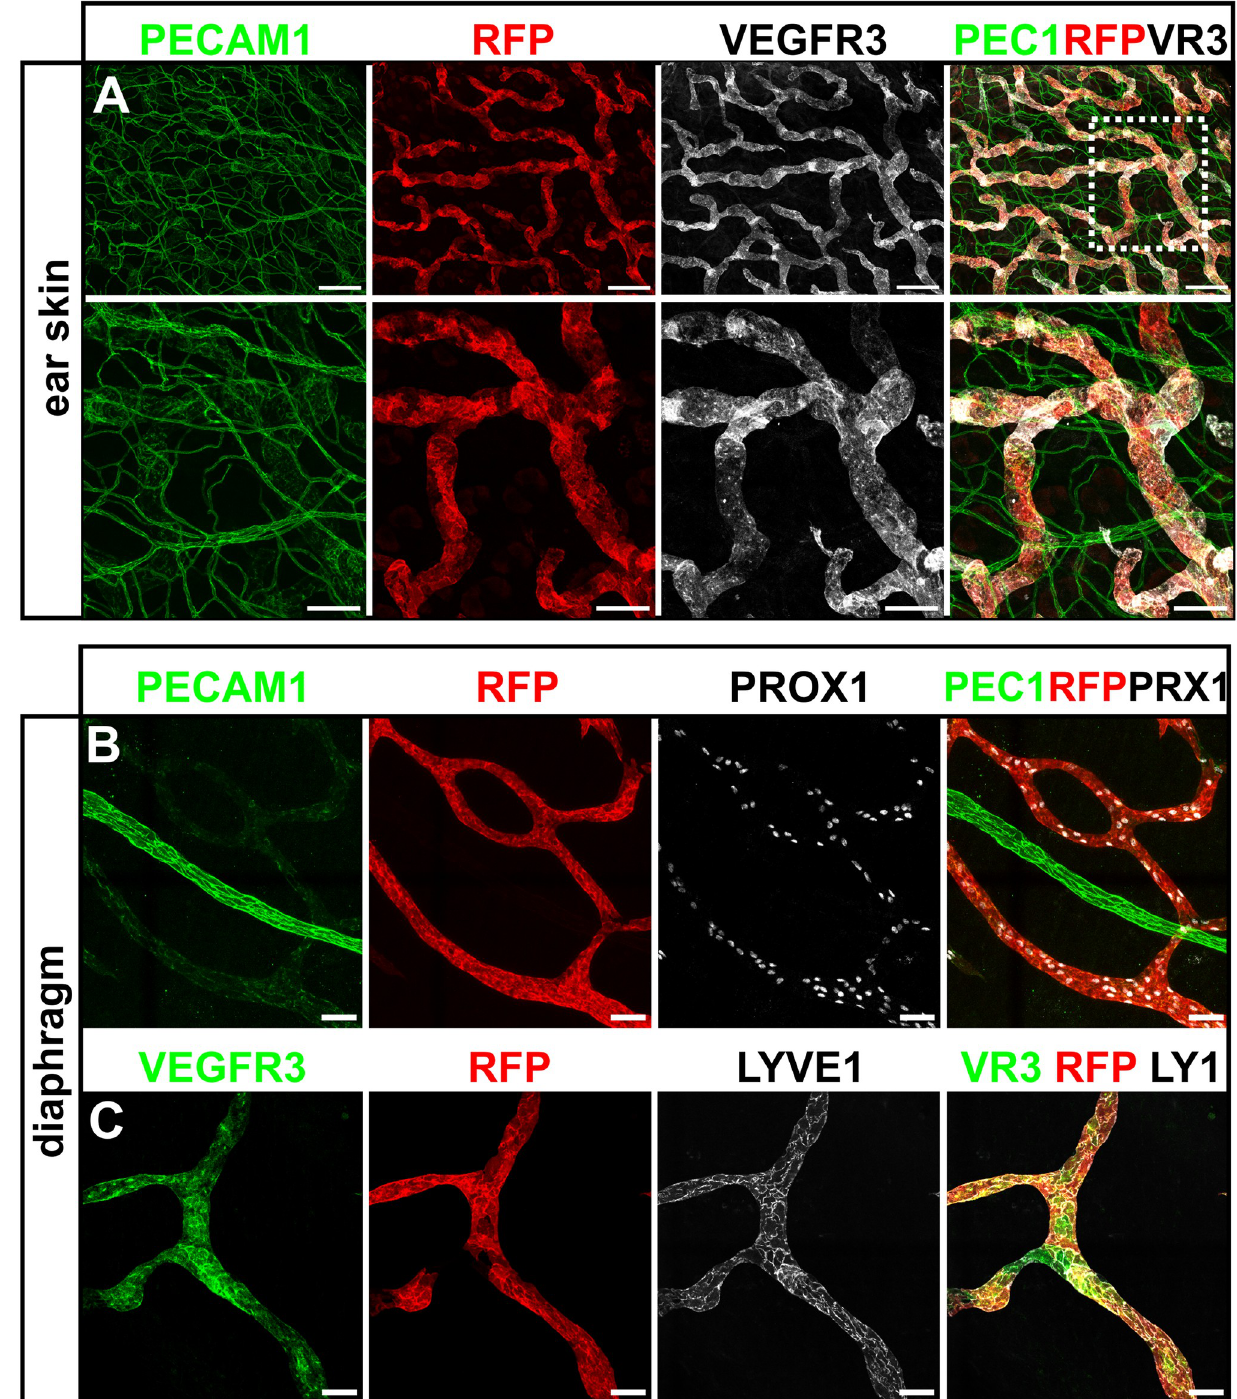
Fig 3. Co-localization of the transgene-derived Vegfr3 -tdTomato signal with bona fide lymphatic vessel markers in the dermis of the ear and diaphragm. A-C) Maximum intensity projection (MIP) of representative confocal tile-scans from wholemount immunostained ear skin (A) and diaphragm (B-C) of adult Vegfr3 -tdTomato transgenic mice. Stained antigens are indicated above each panel. The white boxed area in (A) is magnified in (B). Scale bars = 200 μ m (A), 100 μ m (A, magnification), 50 μ m (B,C).